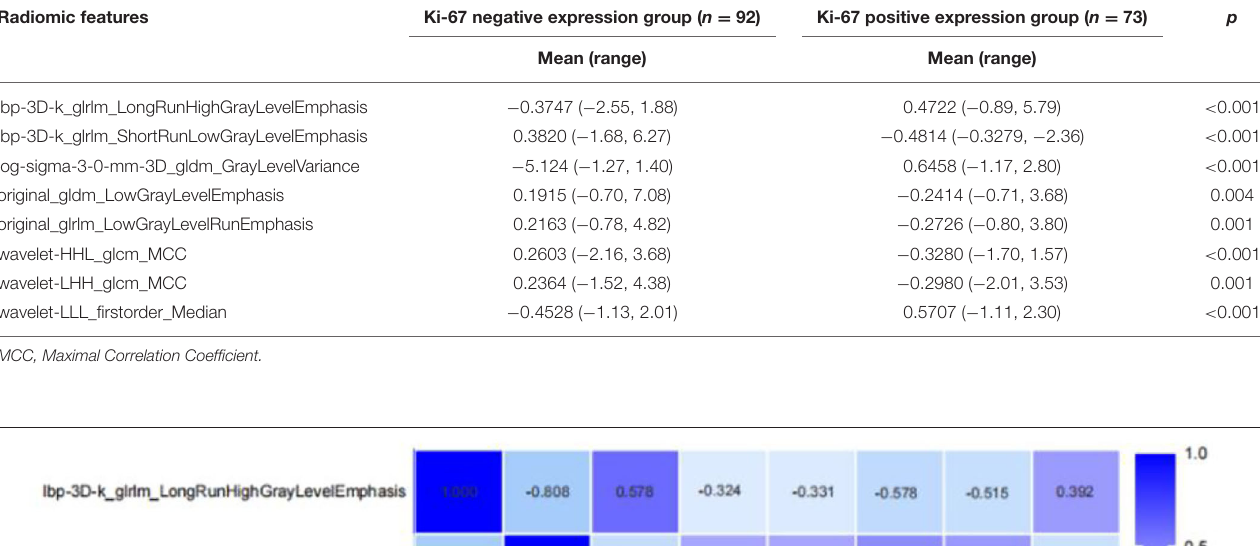
TABLE 6 | Analysis of the radiomic features between negative and positive Ki-67 levels in the training set. Radiomic features